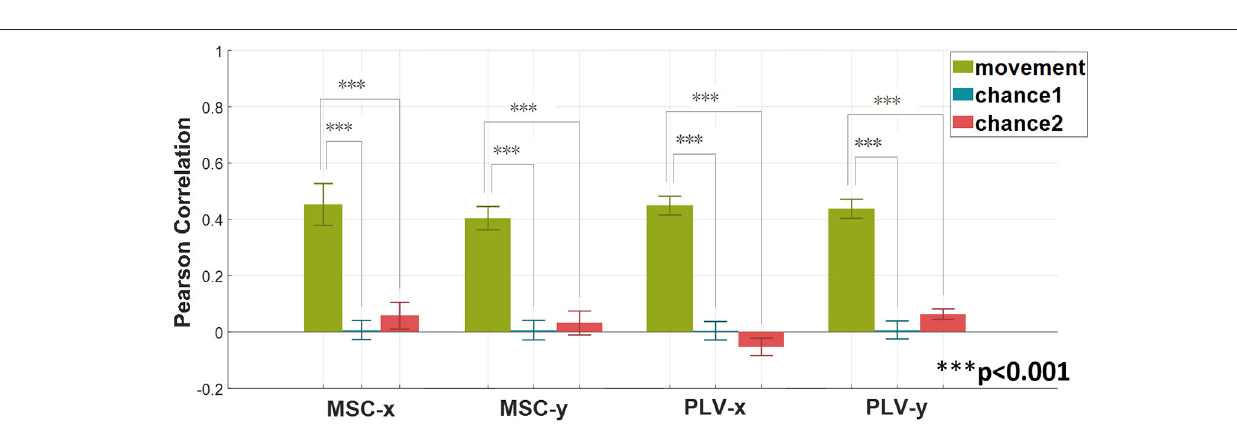
FIGURE 4 | Decoding performance of center-out trajectory reconstruction for MSC and PLV features. The bar plots represent the mean ± SD of the Pearson correlation coefficients for each feature alongside each axis.